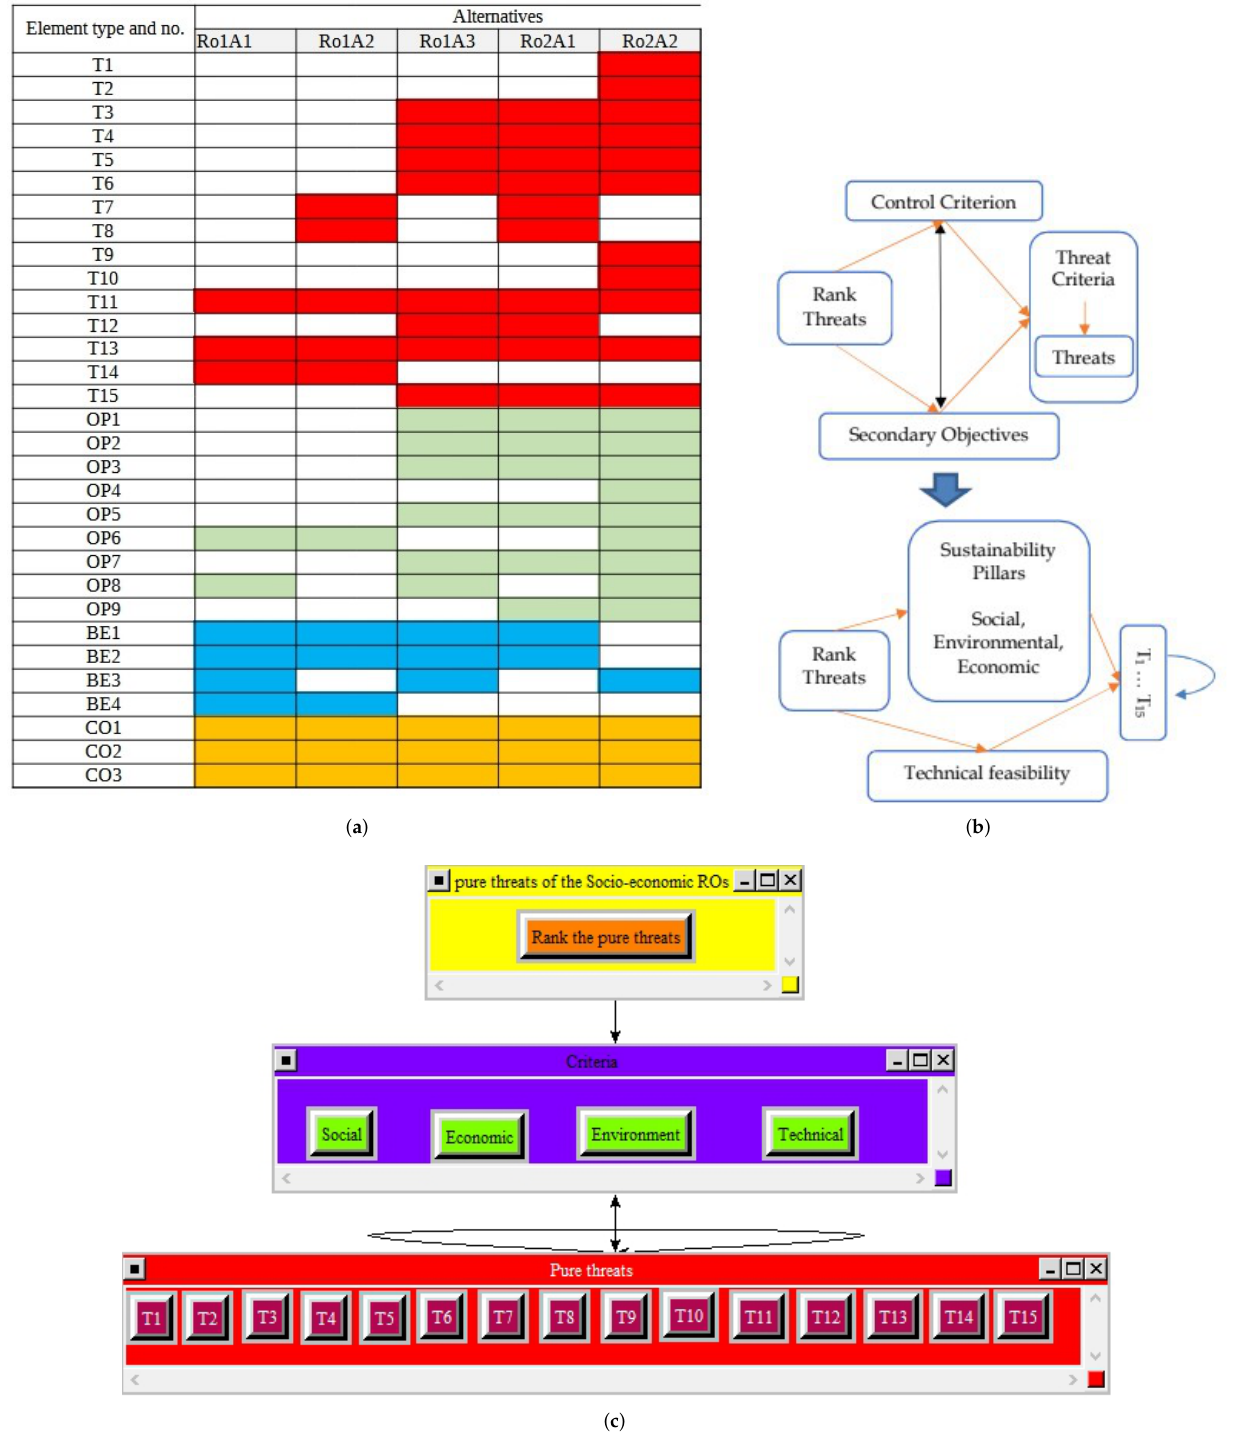
Figure 3. Risk Network of the current study. ( a ) The relation between T, Co, Be, Op and alterna- tives.(The different colors of this sub-figure is just to make a visual separation); ( b ) Risk Network map; ( c ) The Risk network (Elaborated by Super decision Version 3.2. The colors of this sub-figure are output of the Super Decisions